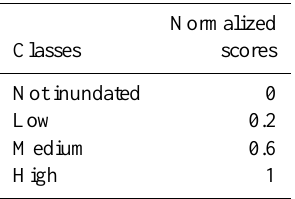
Table 6. Classification and ranking of hazard scores for natural and semi-natural